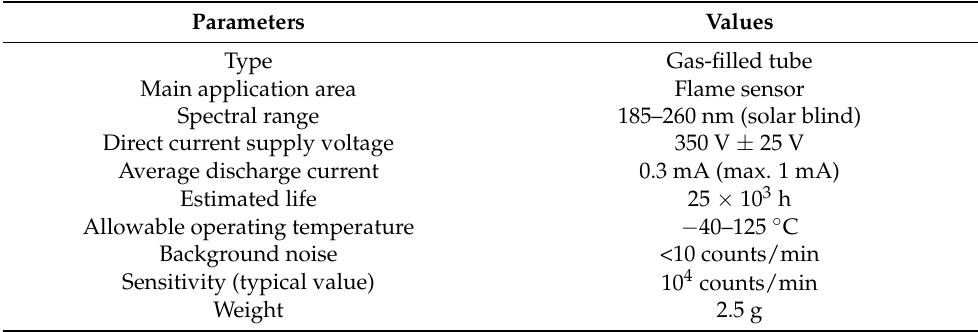
Table 1. Hamamatsu R9533 UVTRON sensor used to detect the UV radiation emitted by the electrical discharges.